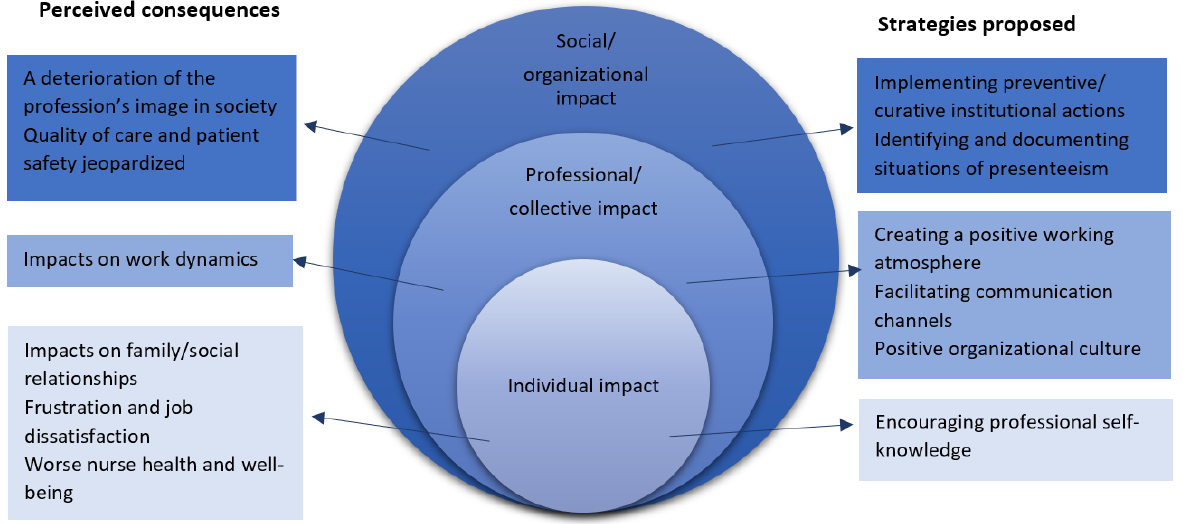
Figure 1. Summary of the findings: consequences of presenteeism and strategies to minimize it inspired by the ecological model of health promotion [27].